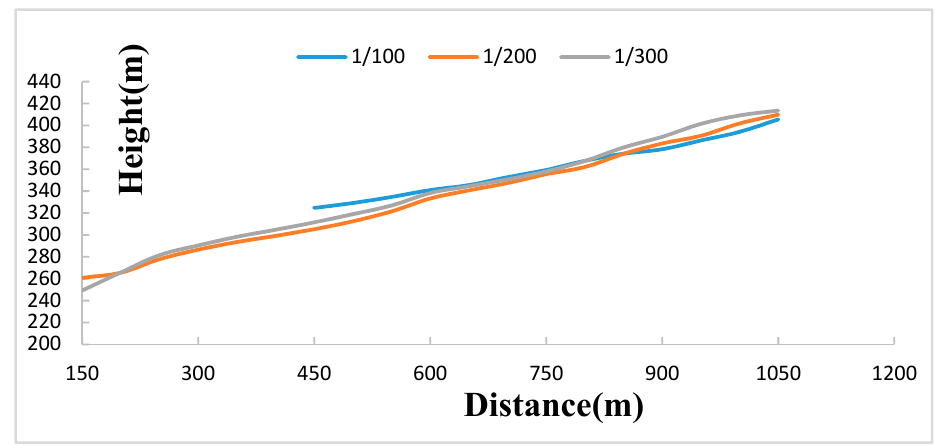
Water 2020 , 12 , x FOR PEER REVIEW Figure 9. The position of the phreatic line under different dry bench length. Figure 9. The position of the phreatic line under di ff erent dry bench length.